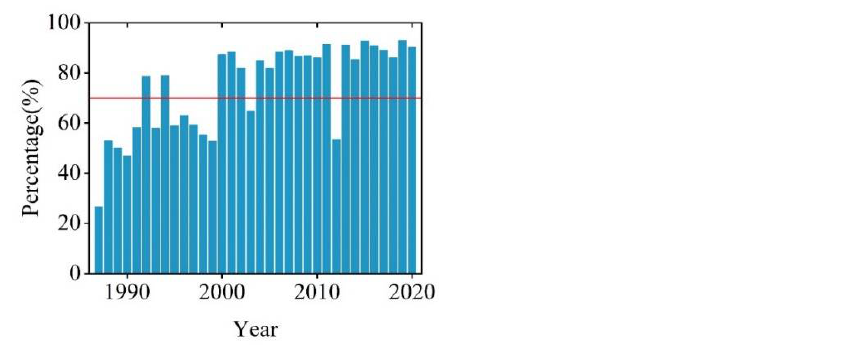
Figure 10. The percentage of valid Landsat pixels’ area in the reference vegetation region for the period 1987 to 2020.